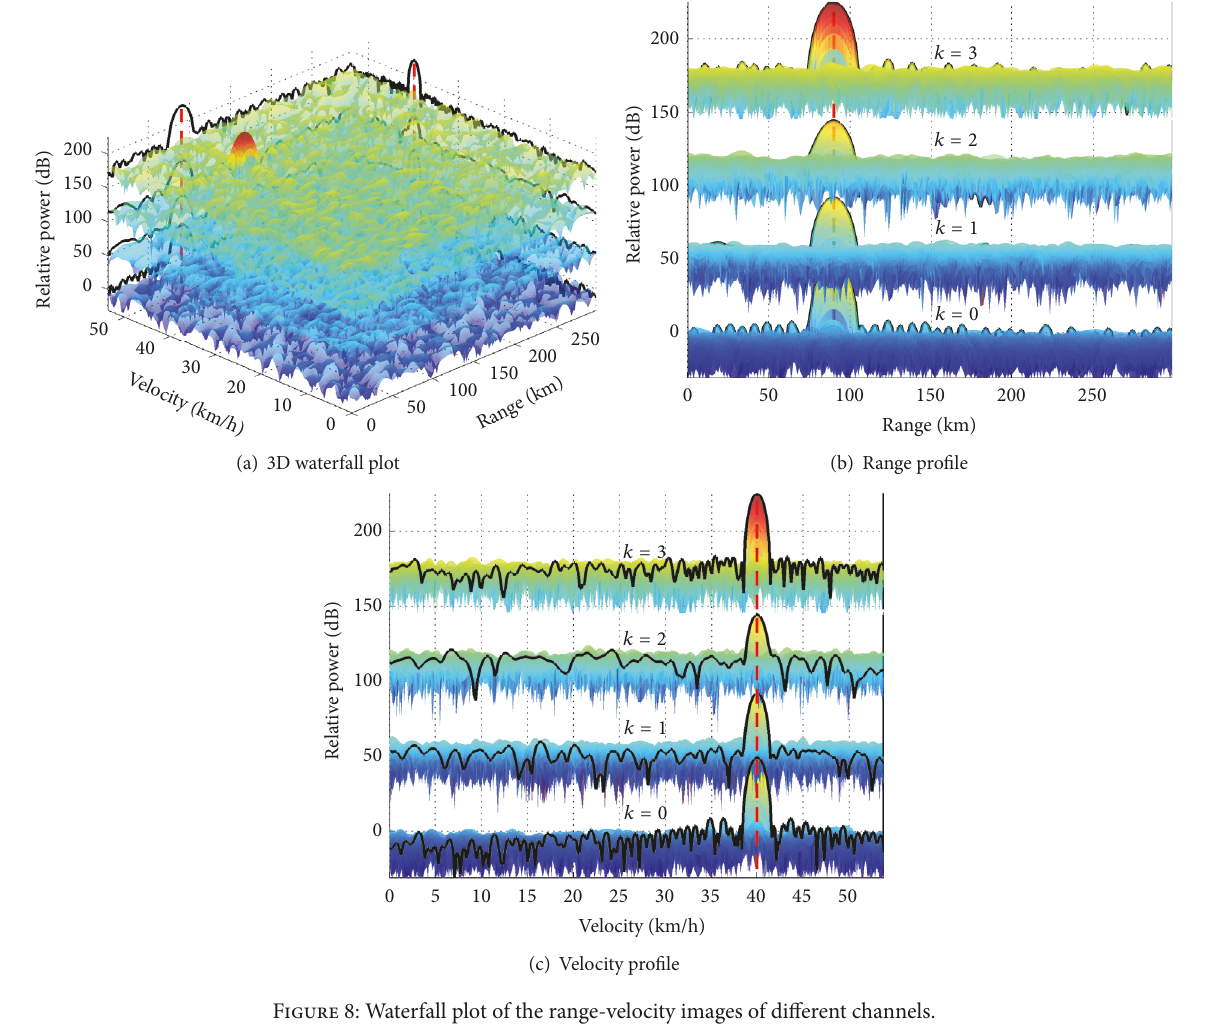
Figure 8: Waterfall plot of the range-velocity images of different channels.